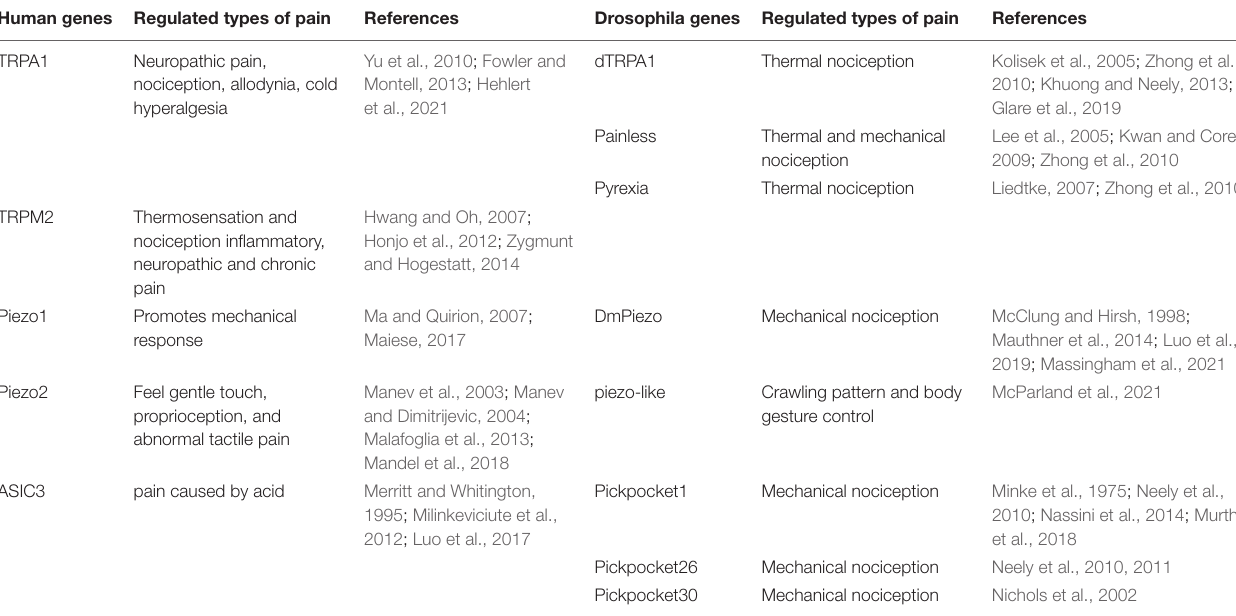
TABLE 1 | Genes that regulate pain in humans and Drosophila